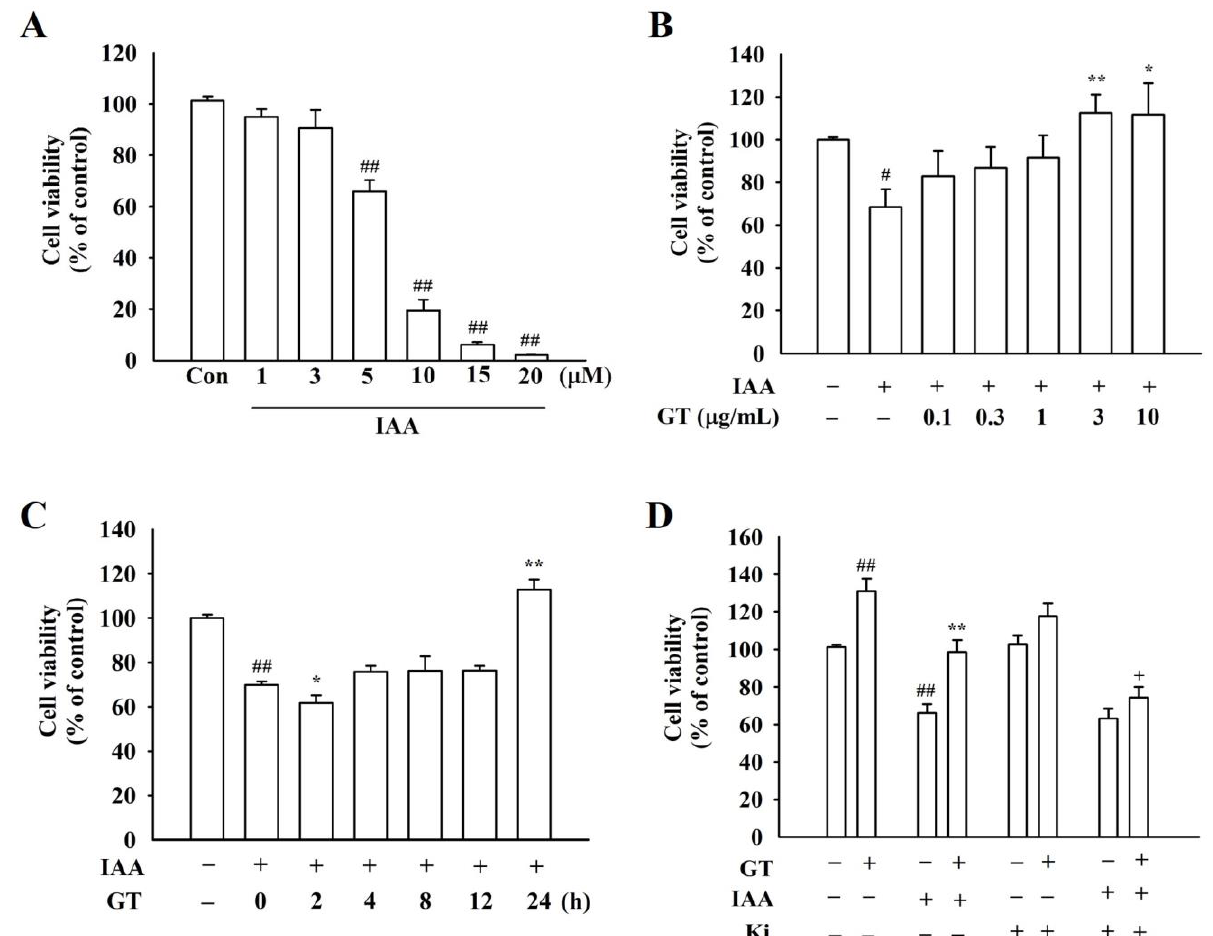
Figure 1. Effects of gintonin on cell viability against iodoacetic acid (IAA)-mediated HT22 cell death. ( A ) IAA-induced cell death in a dose-dependent manner in HT22 cells treated with multiple concentrations of IAA (1, 3, 5, 10, 15, and 20 μM) for 2 h. ( B ) Dose-dependent effect of gintonin on cell viability against IAA-mediated cell apoptosis. After treating with 5 μM IAA for 2 h, HT22 cells were exposed to various concentrations of gintonin (0.1, 0.3, 1, 3, and 10 μg/mL) for 24 h. ( C ) Time-dependent effect of gintonin on cell viability against IAA-mediated cell apoptosis. After treating with 5 μM IAA for 2 h, HT22 cells were exposed to gintonin (3 μg/mL) at various times (2, 4, 8, 12, and 24 h). ( D ) Involvement of LPA1/3 receptors in gintonin-mediated cell protection against IAA. After treating with 5 μM IAA for 2 h, HT22 cells were pre- treated with Ki16425 (final concentration 10 μM), an LPA1/3 receptor antagonist, for 30 min and then co-treated with 3 μg/mL gintonin for 24 h. Cell viability was estimated with the XTT assay kit. The data are represented as the mean ± standard error of the mean (SEM; n = 5). Statistical significances were determined by either one-way ANOVA ( A – C ) or three-way ANOVA ( D ). # p < 0.05 and ## p < 0.01 compared to the control group; * p < 0.05 and ** p < 0.01 compared to the IAA-treated group; + p < 0.01 compared to the GT + IAA group.